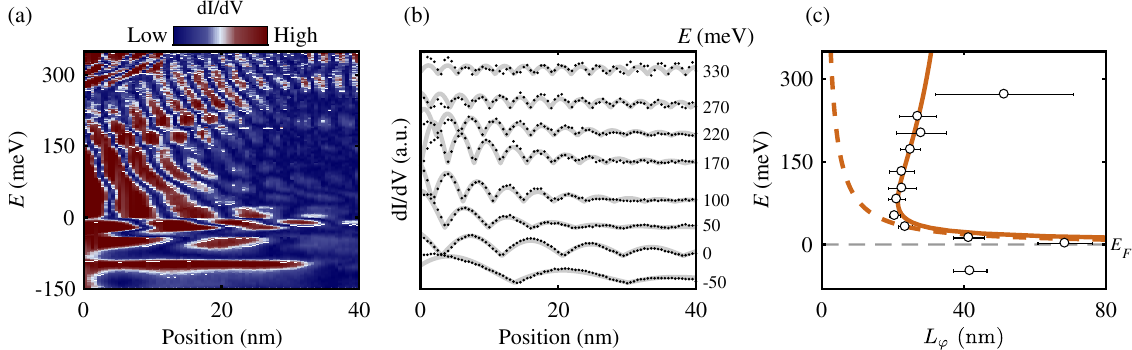
FIG. 2. Nonmonotonic phase coherence length L φ visualized by QPI decay. (a) The dI/dV map from Fig. 1(d) after applying a “ spatial lock-in ” filtration (see Appendix E 1), used to highlight the decay profile of the QPI patterns. The extended standing-wave patterns of the hot holes turn into progressively decaying QPI patterns above E but then revive above about 80 meV. (b) Representative decay profiles F from (a) (dotted lines), each fitted to A j sin ð qx þ Φ Þj e − 2 x=L φ (gray lines). At the highest measured energies, the decay is too slow to fit reliably within the measured distance, which is limited by the distant surface impurities (hence the large error bars). (c) The fitted phase coherence length at different energies, displaying a nonmonotonic evolution with energy (open circles). The calculated phase coherence length from the model (solid line) agrees well with the measured nonmonotonic trend and stands in sharp contrast to the E − 2 behavior expected at the low-energy regime (dashed